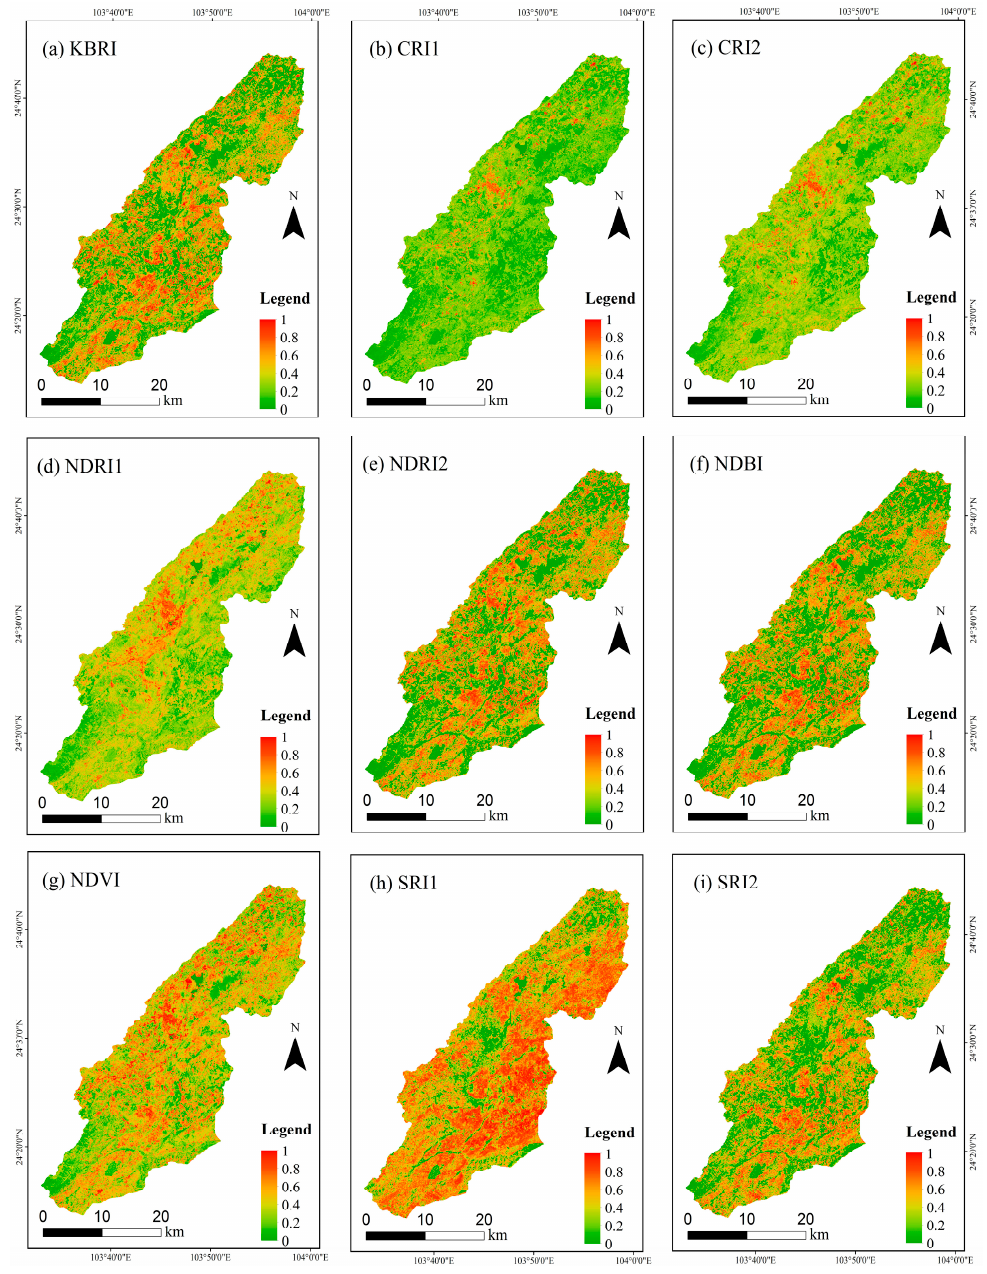
Figure 5. Images of exposed bedrock fractions throughout the whole Xiaojiang watershed developed by the linear-regression models with ( a ) KBRI, ( b ) CRI1, ( c ) CRI2, ( d ) NDRI1, ( e ) NDRI2, ( f ) NDBI, ( g ) NDVI, ( h ) SRI1, and ( i ) SRI2, whose values range from 0 and 1, where 0 represents nonrock areas, and 1 denotes 100% exposed bedrock coverage.